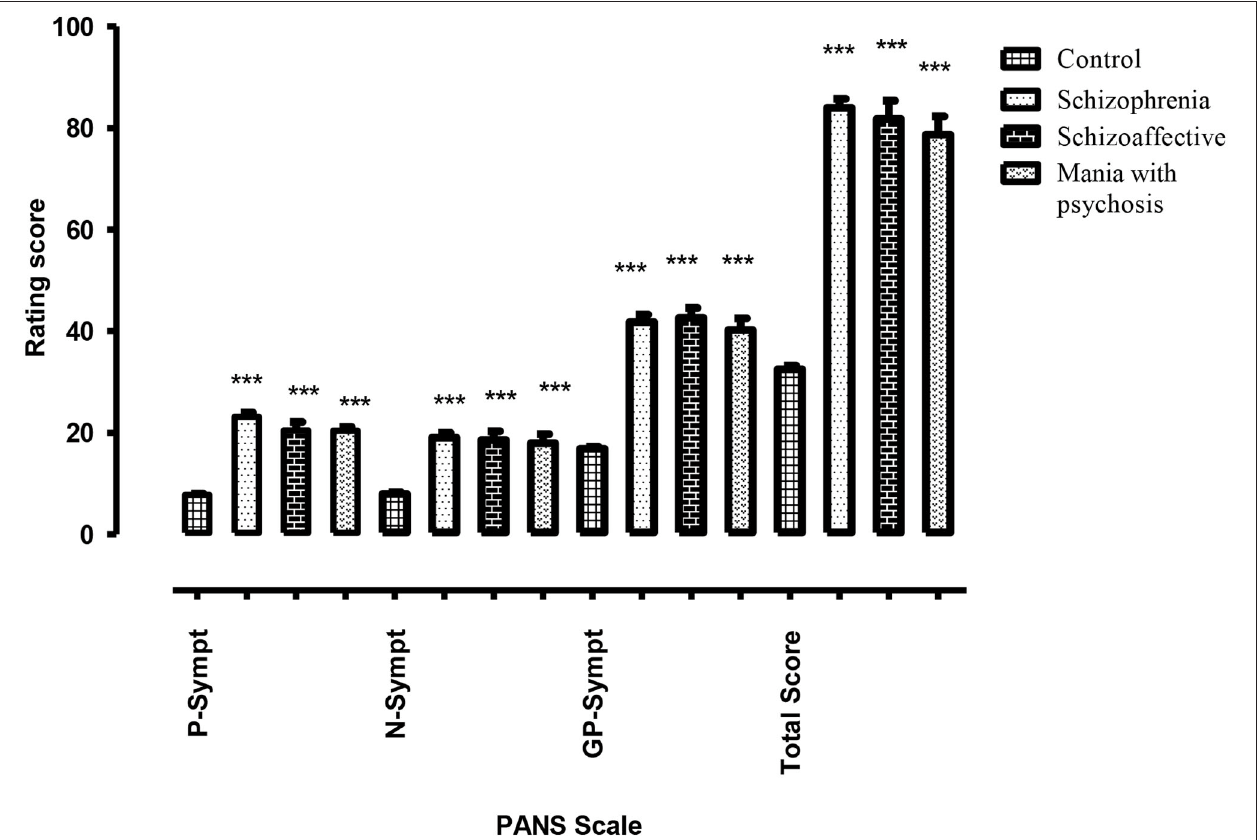
FIGURE 1 | Difference of psychotic symptoms assessed through PANSS (positive, negative, general psychopathology, and total sub-scale) in healthy control subjects vs. test group of psychotic patients with cannabis abuse (schizophrenia, schizoaffective symptoms, and mania with psychosis). *** highly significant.